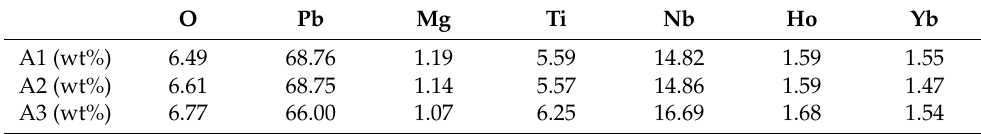
Table 1. The element content of the PMN-32PT: Ho 3+ /Yb 3+ crystals obtained by EDS.